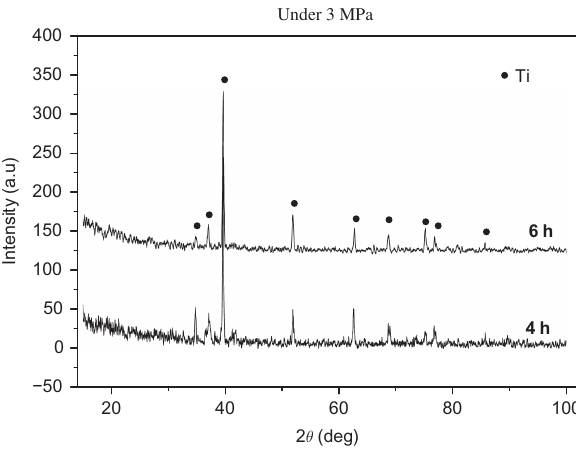
Figure 7: XRD spectra of the electrolyzed products at 1,100 ℃ for 4 and 6 h; the pellets were pressed under 3